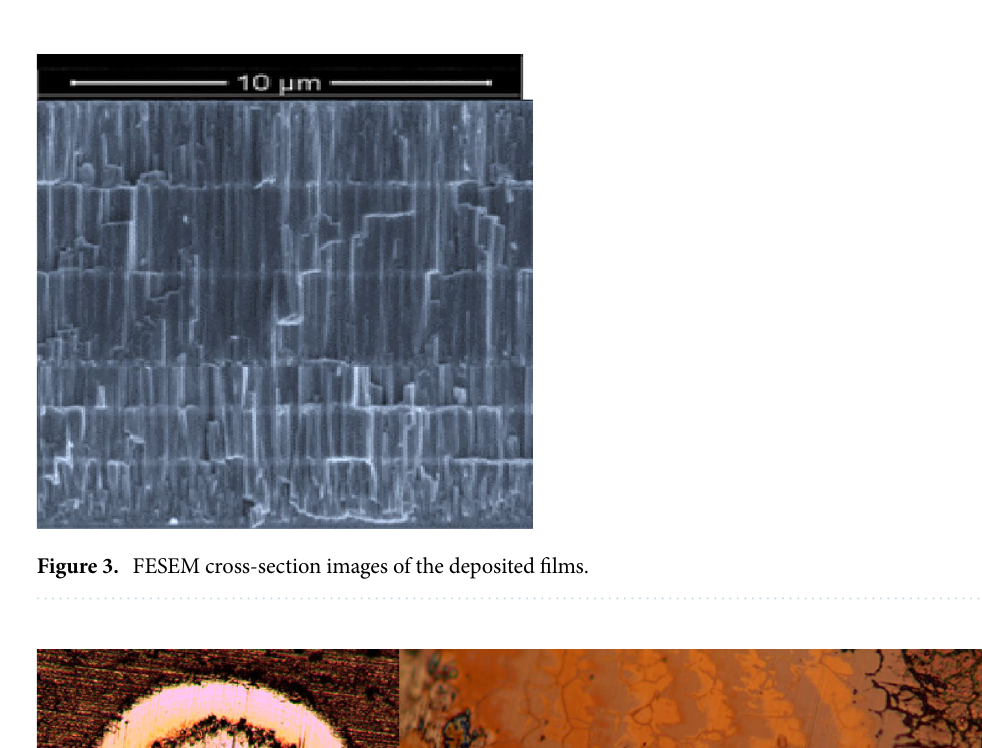
Figure 2. Calotest image of poorly adhered coating.